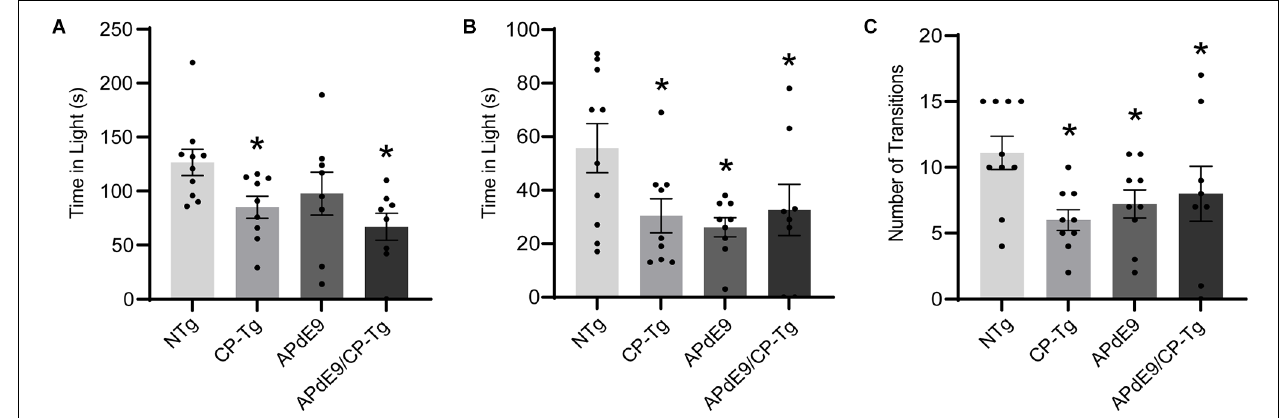
FIGURE 2 | Prostacyclin overexpression increased anxiety-like behavior as measured by light-dark and elevated plus-maze tests. (A) CP-Tg and APdE9/CP-Tg mice spent significantly less time in the light during light-dark exploration. (B) In the elevated plus-maze, all transgenic mouse lines spent significantly less time in the lit arms and made fewer transitions between the open and closed arms (C) of the elevated plus-maze. Bars are means ± SEM, n = 8–10 mice per group. * p < 0.05 compared to NTg mice.